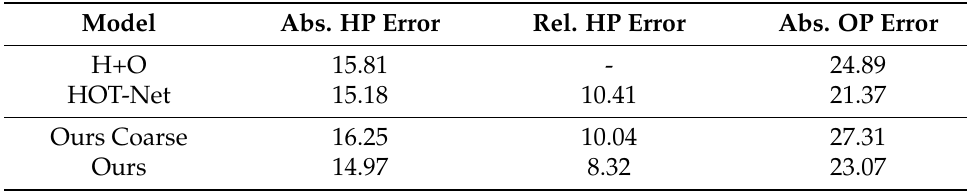
Figure 4. Comparison with state-of-the-art methods on PCP curve and 3D PCK curve. Table 1. Comparison with state-of-the-art methods on FPHA-HO. The mean 3D distance error (mm) is used as metric (Lower is